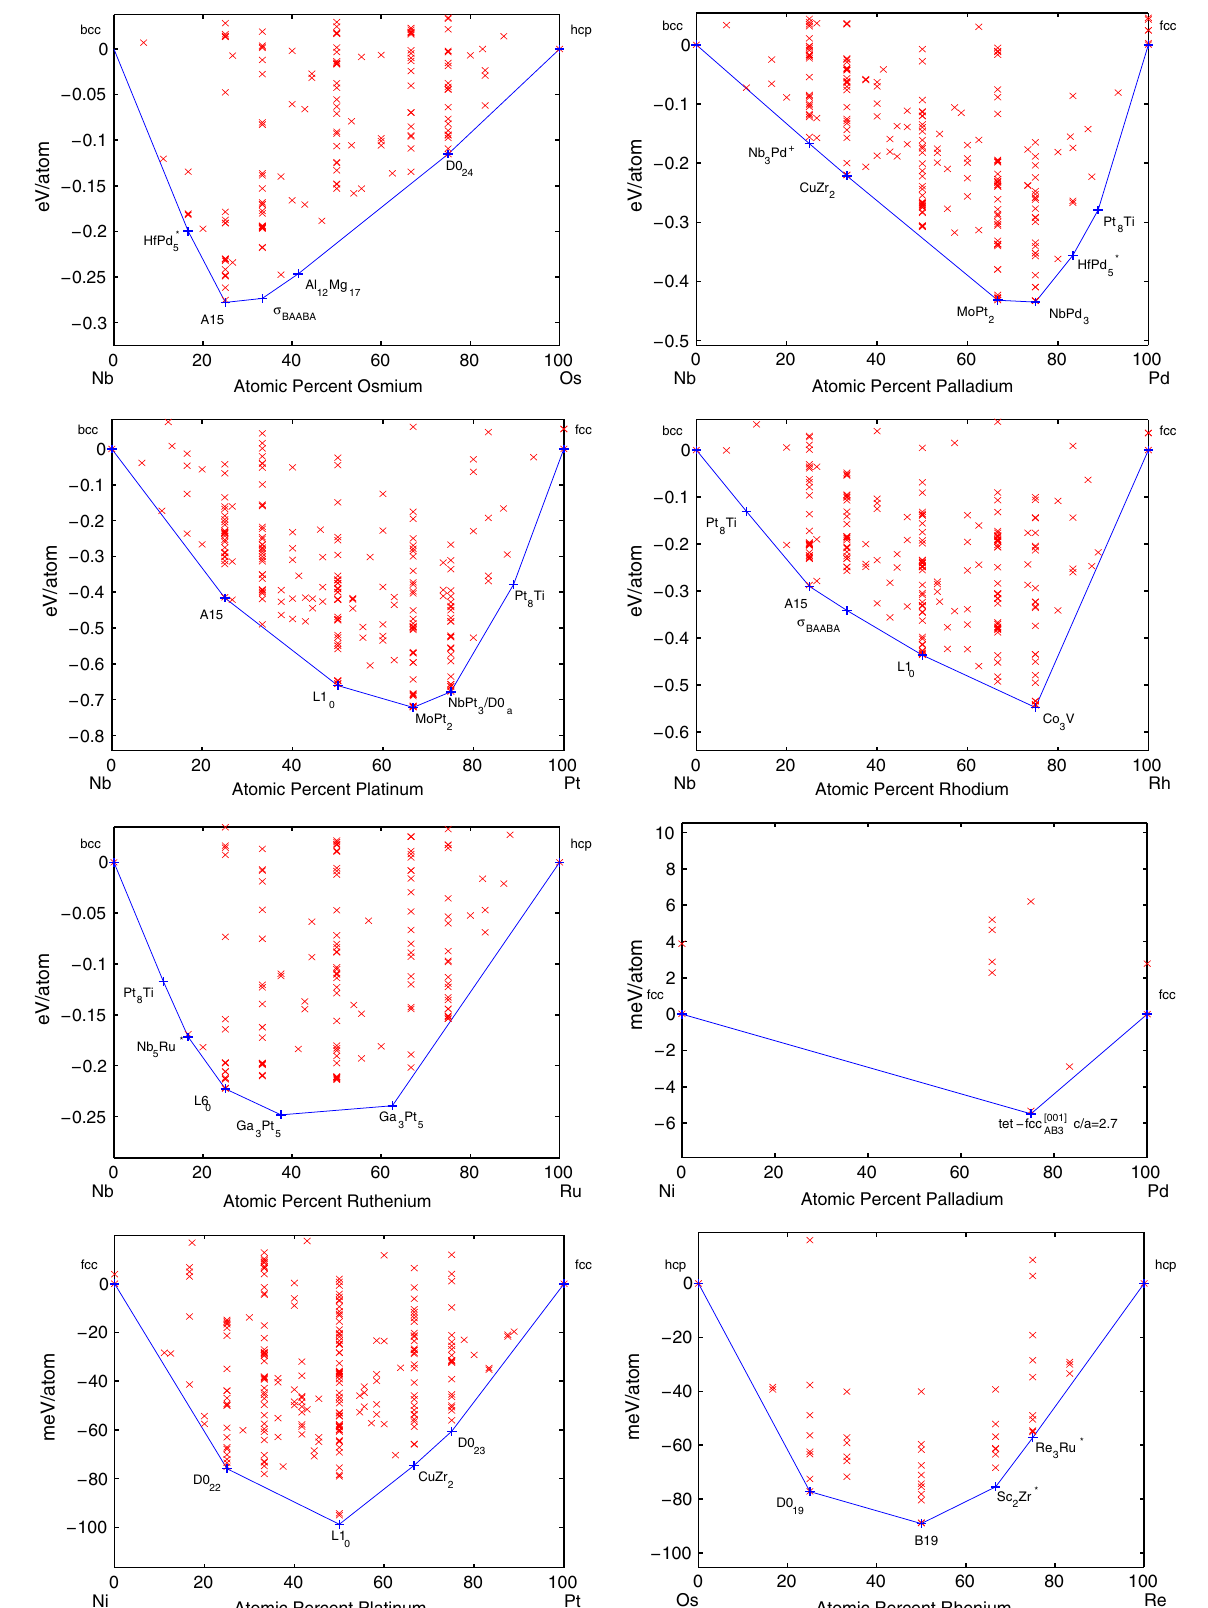
FIG. 12. Convex hulls for the systems Nb-Os, Nb-Pd, Nb-Pt, Nb-Rh, Nb-Ru, Ni-Pd, Ni-Pt, and